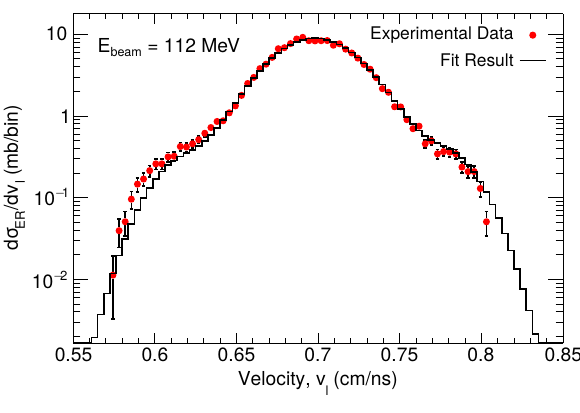
Figure 3. The laboratory-frame velocity distribution at E beam = 112 MeV, where the experimental data are shown as red points, and the result of the correction routine is shown as a black histogram. Both the experimental and fitted distributions are fil- tered by the SOLITAIRE transmission e ffi